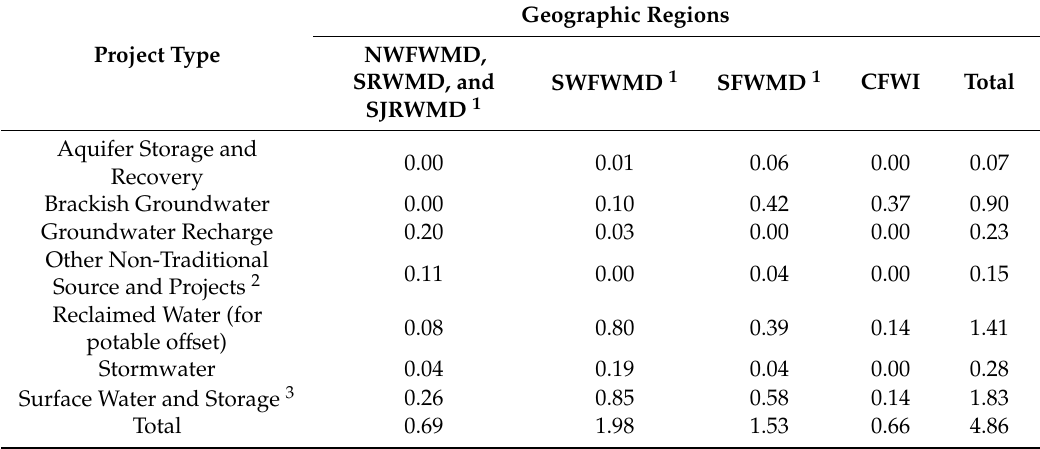
Table 5. Total capacity of the projects that had not yet been completed, by type and geographic region (million cubic meters per